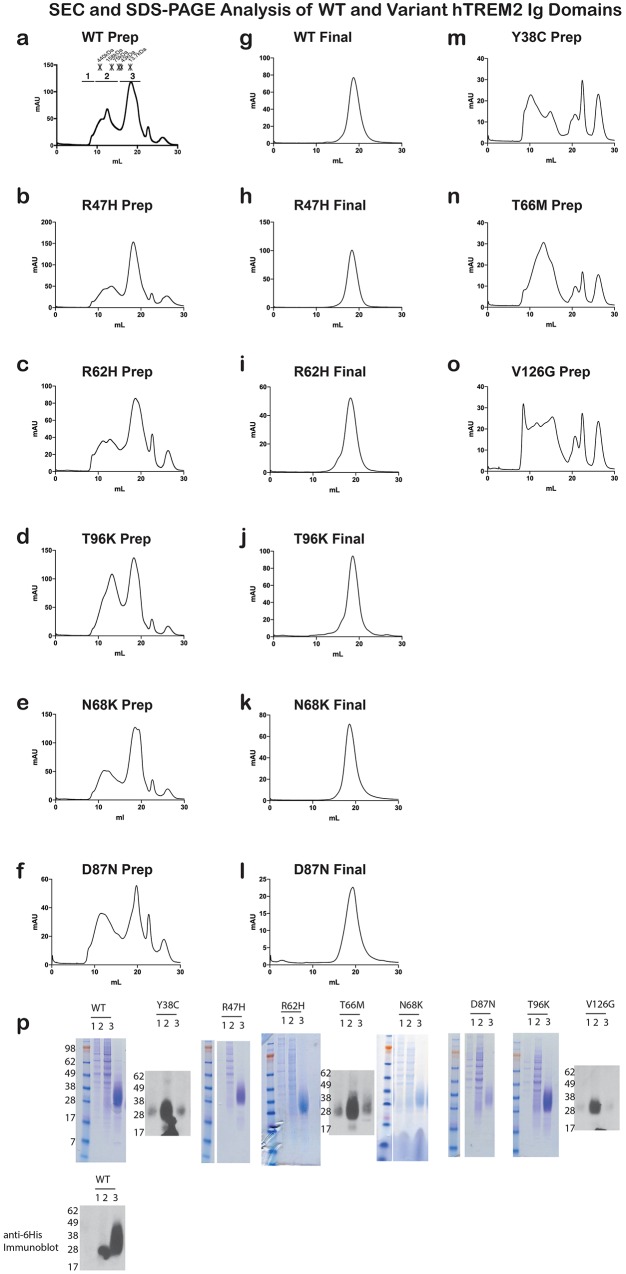
Analysis of WT and variant TREM2 ectodomains by size exclusion chromatography.(a-f) Preparative SEC chromatograms of WT and validated (R47H and R62H) and possible (N68K, D87N and T96K) AD risk variant hTREM2 ectodomains harvested from 293F suspension cells. Fractions were pooled as shown in (a) for SDS-PAGE analysis (r). Fraction volumes corresponding to 1) aggregate;, 2) oligomer, and 3) monomer TREM2 are indicated. Asterisks (*) in (a) indicate elution volumes of MW standards. Fraction 3 contains purified hTREM2 ectodomains that elute as a monomer. This fraction was concentrated and re-run. (g–l) Analytical SEC chromatograms of purified WT and validated and possible AD risk variant hTREM2 ectodomains showing that they elute as monomers without detectable aggregation. (m–o) Preparative SEC chromatograms of hTREM2 NHD mutant ectodomains harvested from 293F suspension cells. These mutants do not yield folded TREM2 protein and largely elute as aggregates and oligomers. (p) SDS-PAGE analysis of WT and validated and possible AD risk variant TREM2 ectodomain preparative traces. Fractions 1, 2, and 3 are indicated as denoted in (a). TREM2 NHD mutant ectodomains were analyzed by anti-6His western blots because they have minimal yields of purified protein that are not readily detectable by SDS-PAGE staining. The AD risk variants elute similarly to WT, while NHD mutants elute as aggregates/oligomers.